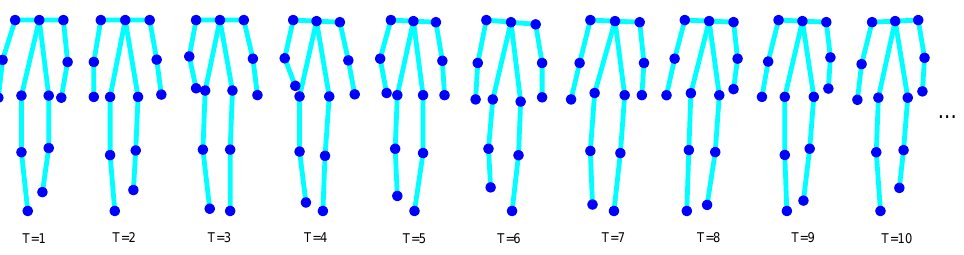
Figure 2. A visualization of samples in PD-Walk